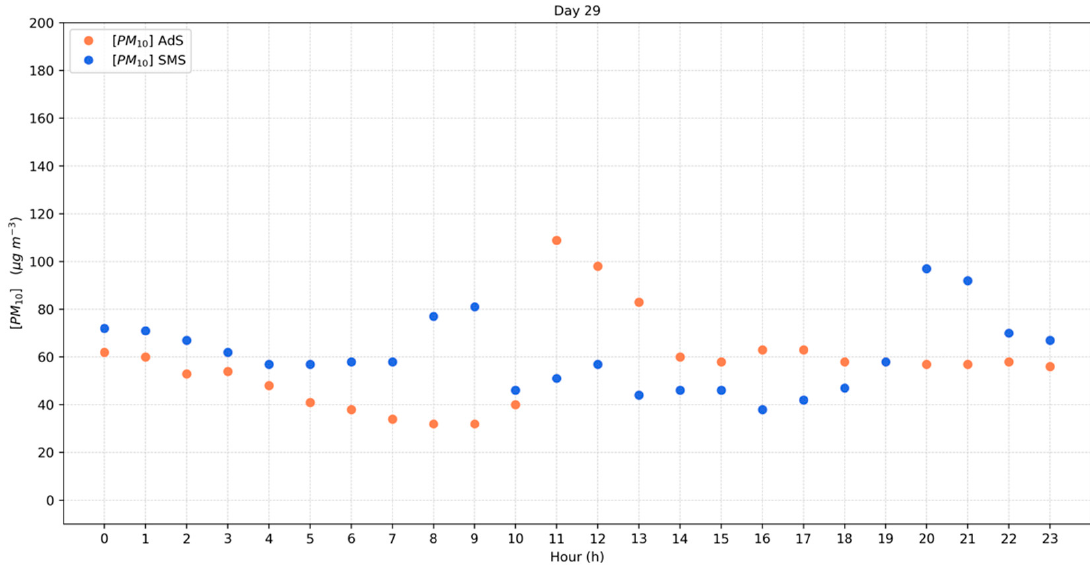
Figure 5. Hourly average concentrations of PM 10 during 29 September 2021 at two AURA rural monitoring stations (AdS: Aiello del Sabato; SMS: San Michele di Serino).